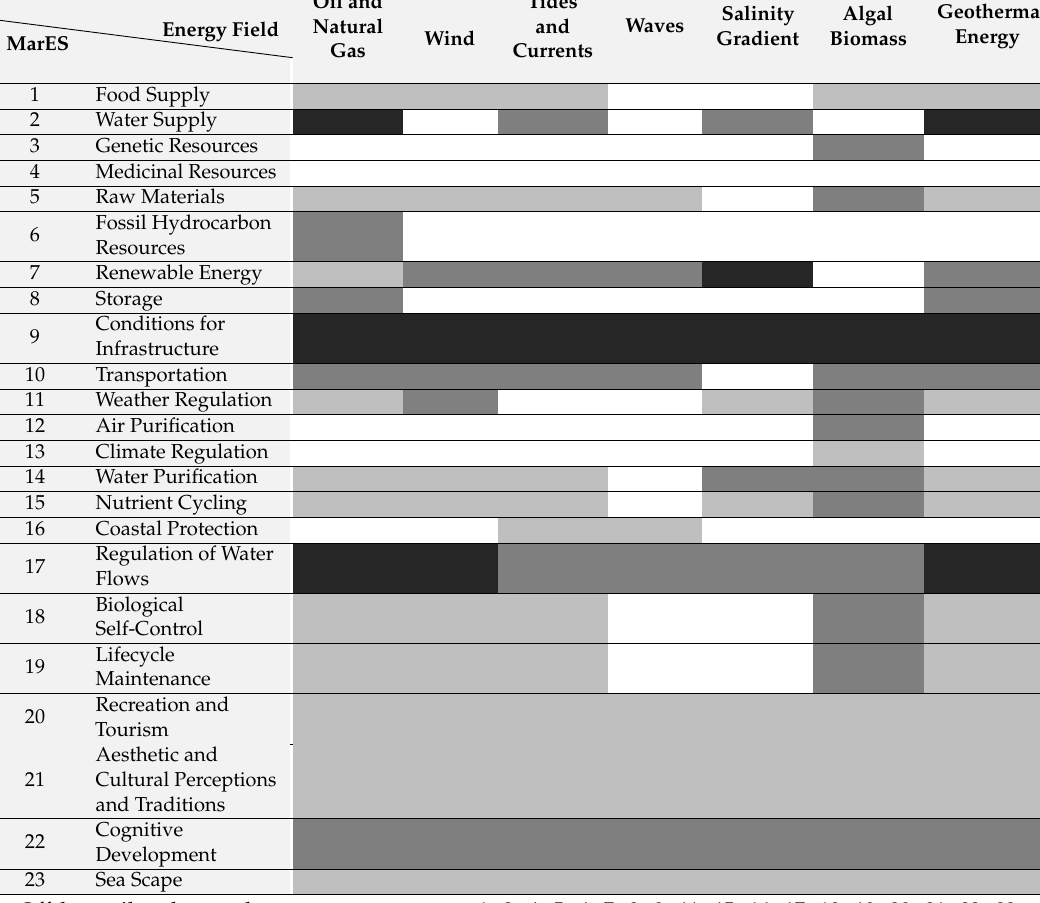
Table 3. The interactions between the energy fields (columns) and the respective marine ecosystem services (MarES) (rows). The table displays the energy fields that use offshore oil and natural gas, offshore wind, tides and ocean currents, waves, salinity gradients, algal biomass, and offshore geothermal energy. Interactions are divided into four categories which are indicated by the colouring of each table element: Dependence (black) means that an energy field needs the respective MarES to function; impact (light grey) indicates a direct, immediate positive or negative influence of the energy field on the MarES that alters its quality or quantity; bidirectional interaction (dark grey) relates to both a dependence and an impact, while no interaction (white) refers to neither. The interactions may counteract or amplify each other. The determination of the interactions is based on the following references, respectively. The references are allocated to each field; the numbers represent the MarES. Oil and Tides Geothermal Salinity Algal Waves Natural and Energy Field Wind Gradient Biomass MarES Gas Currents